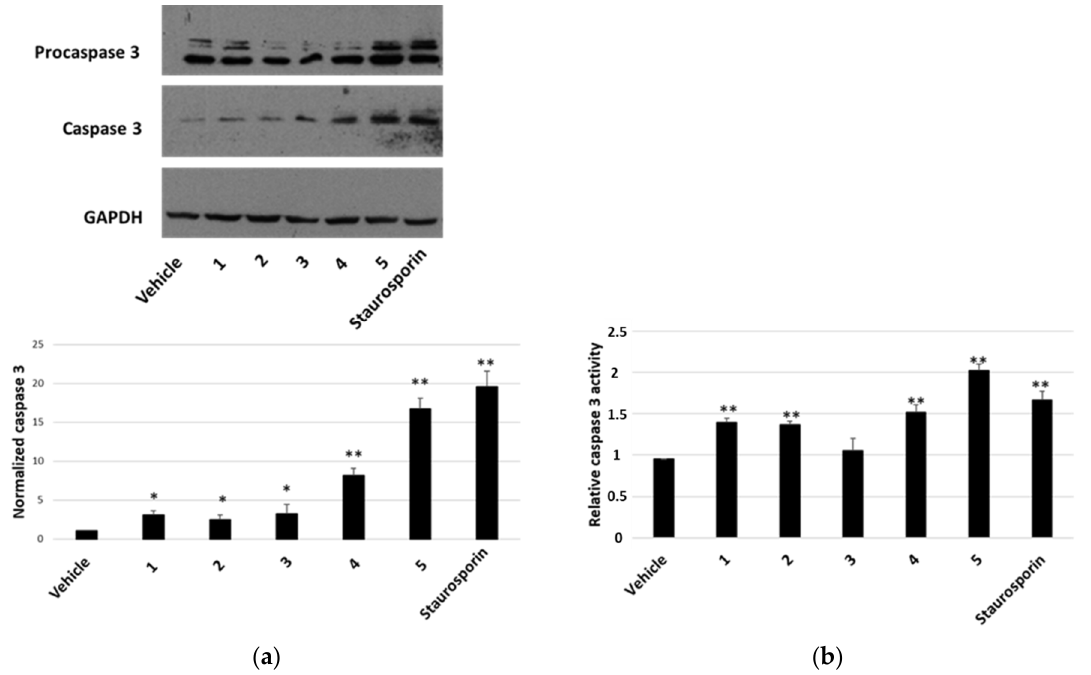
Figure 6. Caspase-3 activation in HepG2 cells. (( a ), upper panel) Representative Western blot anti- caspase 3 on 70 μ g of proteins from cells treated for 7 h with 2 μ M of each compound or vehicle or staurosporin. (( a ), lower panel) Densitometric analysis relative to cleaved caspase-3, performed on three independent Western blots. Protein levels are normalised with respect to the GAPDH expression and reported as variation with respect to the vehicle. Data are reported as mean ± SE. * p < 0.05 and ** p < 0.01 vs. vehicle-treated cells. ( b ) Relative caspase-3 activity, normalised towards activity measured in untreated cells. Data are reported as mean ± SE of three independent experiments. ** p < 0.01 vs. vehicle-treated cells.